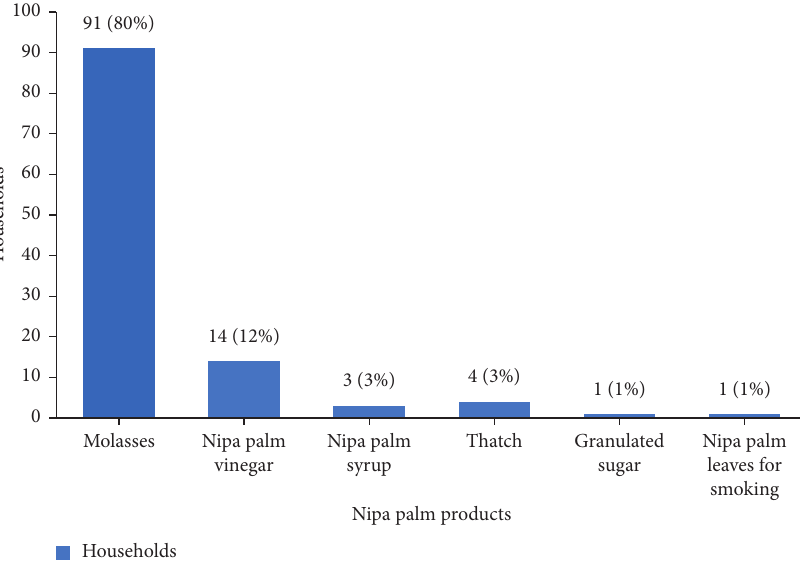
Figure 5: Nipa palm products and production volume in Khanap Nak and Pak Phanang.